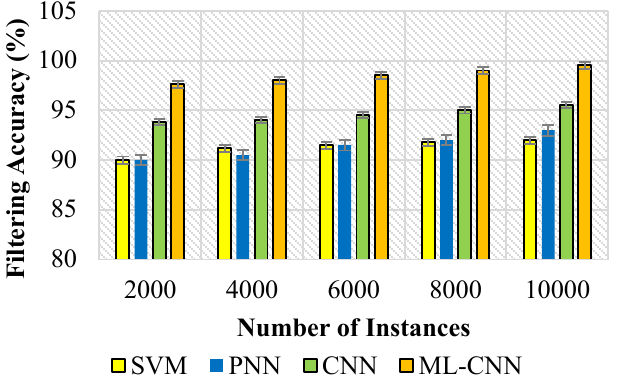
Figure 13. Filtering accuracy vs. number of instances .